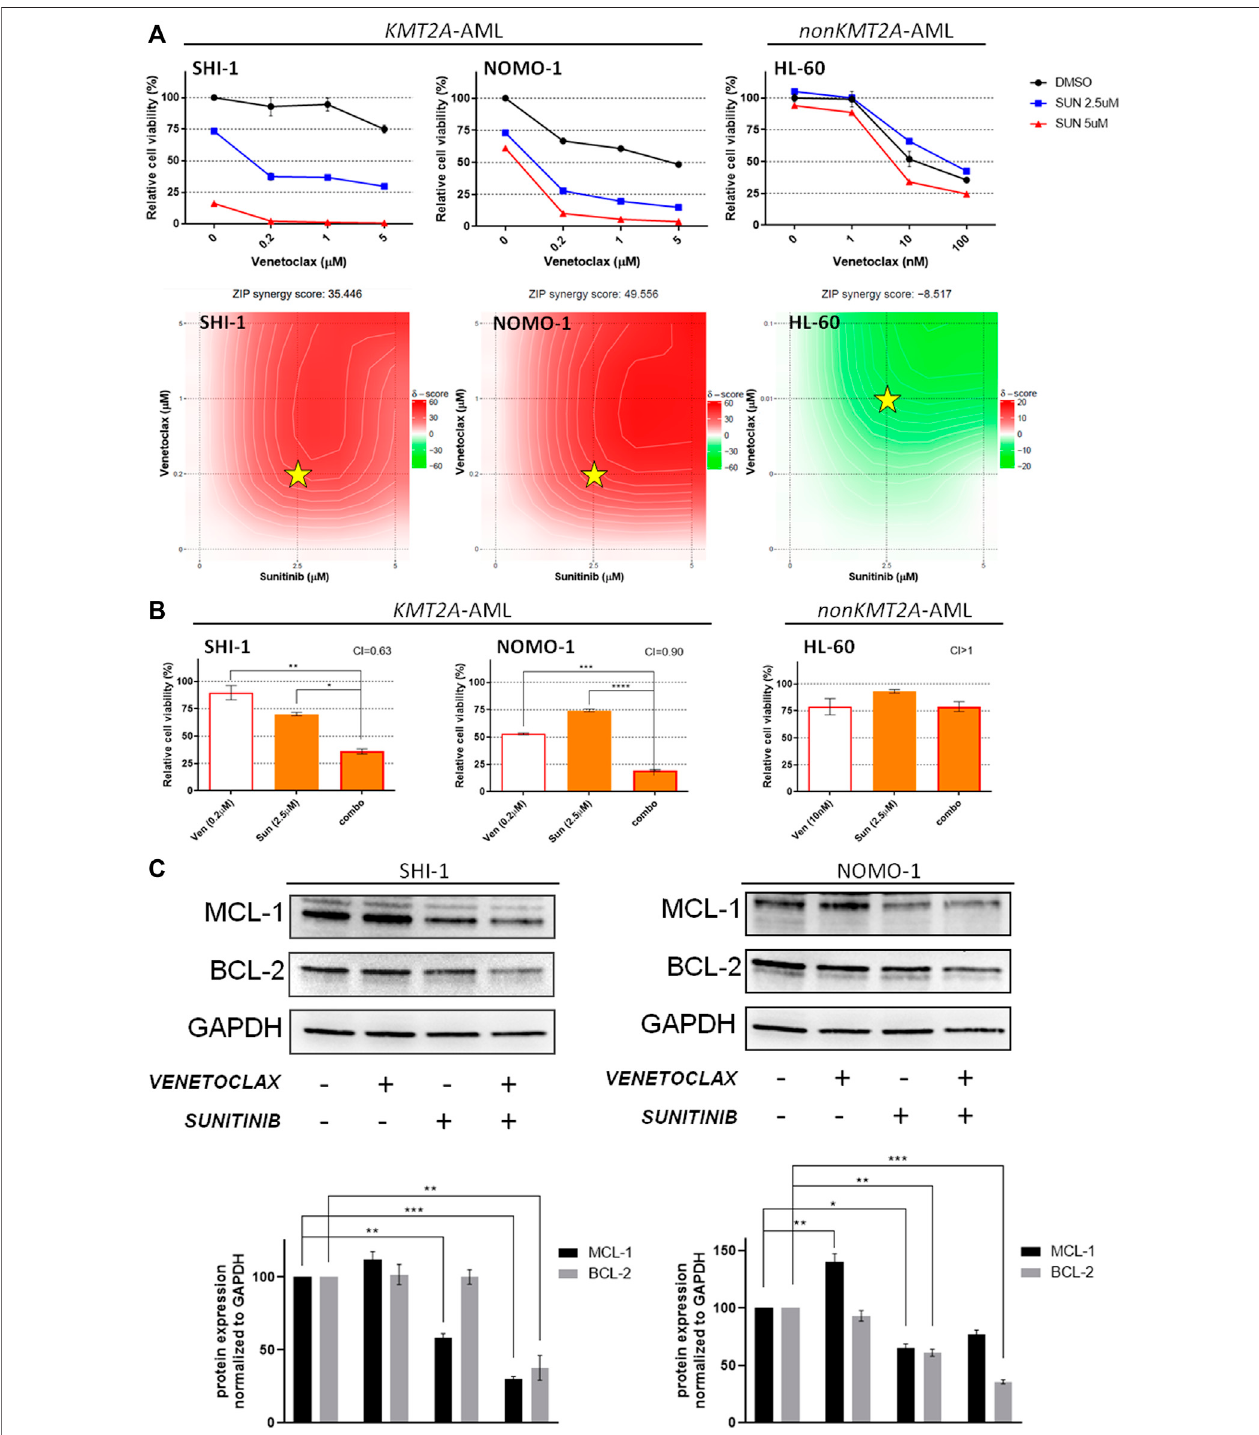
FIGURE 3 | Combination of venetoclax and sunitinib. ( A ) Cell viability of SHI-1 and NOMO-1 [both KMT2A-rearranged acute myeloid leukemia (AML)] and HL-60 (non-KMT2A-rearrangedAML)after treatmentwithsunitinibcombinedwithvenetoclaxat48 haftertreatment.Thesynergyscoreswererepresented bypseudocoloring 2-dimensionalcontourplotsover thedosematrix(redindicates synergyand green indicates antagonism)andcalculatedusing theZIPmodel(synergywhen > 10, n =2). Stars indicate the concentrations selected for subsequent experiments. ( B ) Cell viability of SHI-1 and NOMO-1 (KMT2A-arranged) or HL-60 (non-KMT2A- rearranged)aftertreatmentwithvenetoclax,sunitinib,orthecombinationat48 haftertreatment(CI,combinationindex;synergywhenCI < 1.ANOVAtestwasperformed by applying Bonferroni correction for multiple statistical hypotheses testing. * p < 0.05; ** p < 0.01, *** p < 0.001; **** p < 0.0001; n = 2). ( C ) MCL-1 and BCL-2 levels measuredat48 hpost-treatmentinSHI-1andNOMO-1.Histogramsreportthequanti fi cationnormalizedtoGAPDH.ANOVAtestwasperformedbyapplyingBonferroni correction for multiple statistical hypotheses testing. * p < 0.05, ** p < 0.01, *** p < 0.001; n = 2.